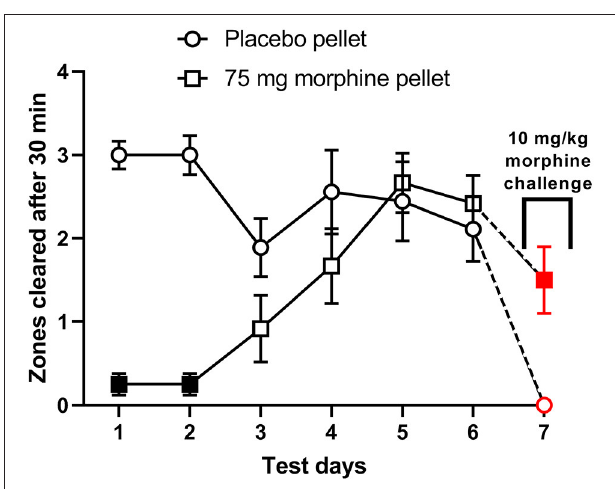
FIGURE 6 | Effect of repeated morphine treatment on body weight. Percent change in body weight from baseline of mice treated repeatedly with saline, 1.0 mg/kg, 3.2 mg/kg or 10 mg/kg morphine s.c. Data are mean ± SEM and analyzed by two-way repeated measures ANOVA. Filled points indicate statistical significance ( P < 0.05) vs. saline indicated by a main effect of treatment by repeated measures two-way ANOVA with Bonferroni’s test. Saline (6/day), 1.0 mg/kg morphine (6/day), 3.2 mg/kg morphine (7/day) and 10 mg/kg morphine (5/day).